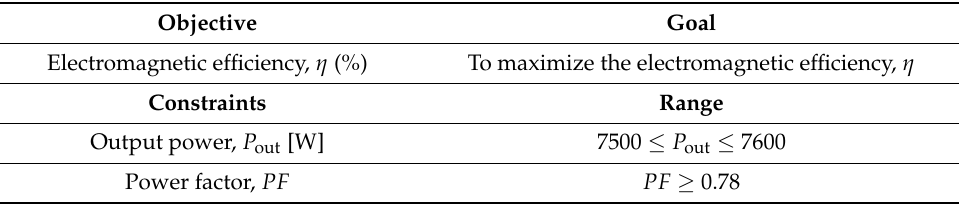
Table 2. Objective and constraints of the optimization